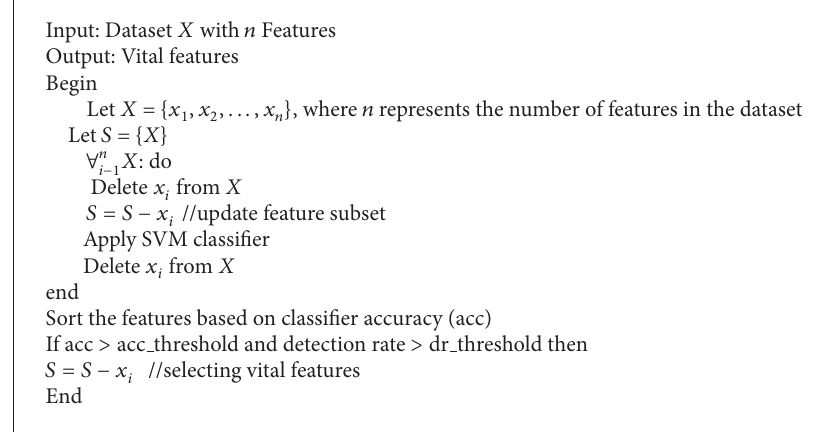
Algorithm 3: Random feature selection method.